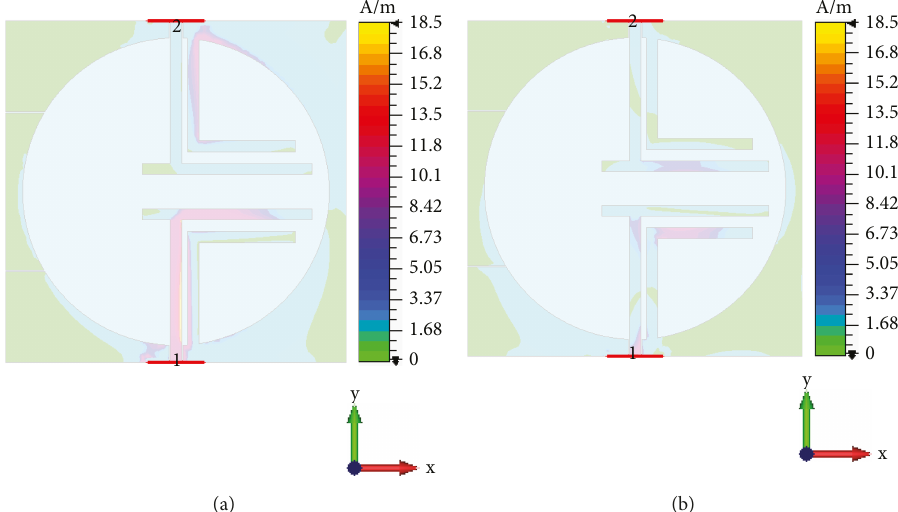
Figure 3: Current distribution of the proposed antenna without the isolation structure (a) at 0.75GHz and (b) at 1.9GHz.